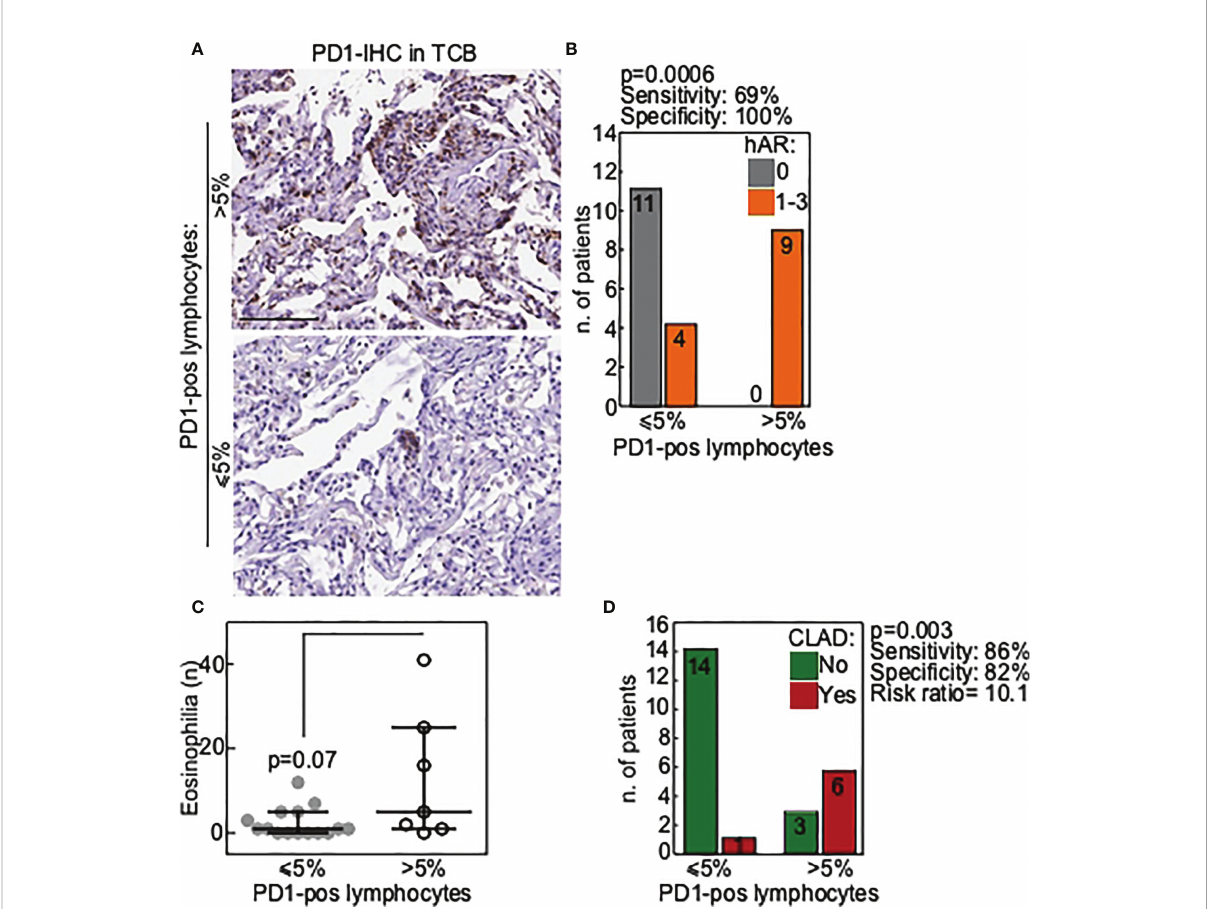
FIGURE 1 PD1 is a marker of poor allograft outcome in transbronchial cryobiopsies of LTx patients. (A) Representative images of TCB with a lymphocytic in fi ltrate positive for PD1 (>5% of positive lymphocytes; upper panel) or negative ( ≤ 5% of positive lymphocytes; lower panel). Scale bars, 100 m m. (B) Correlation of PD1-positive TCB with histological diagnosis of acute rejection (hAR grade A). P value is from Fisher exact test. (C) Presence of eosinophilia in BAL was correlated with PD1-positive TCB. Each dot is a case and lines indicate median with IQR. P value is from Mann-Whitney U test. (D) Correlation of PD1-positive TCB with occurrence of chronic lung allograft dysfunction (CLAD) during follow-up. P value is from Fisher exact